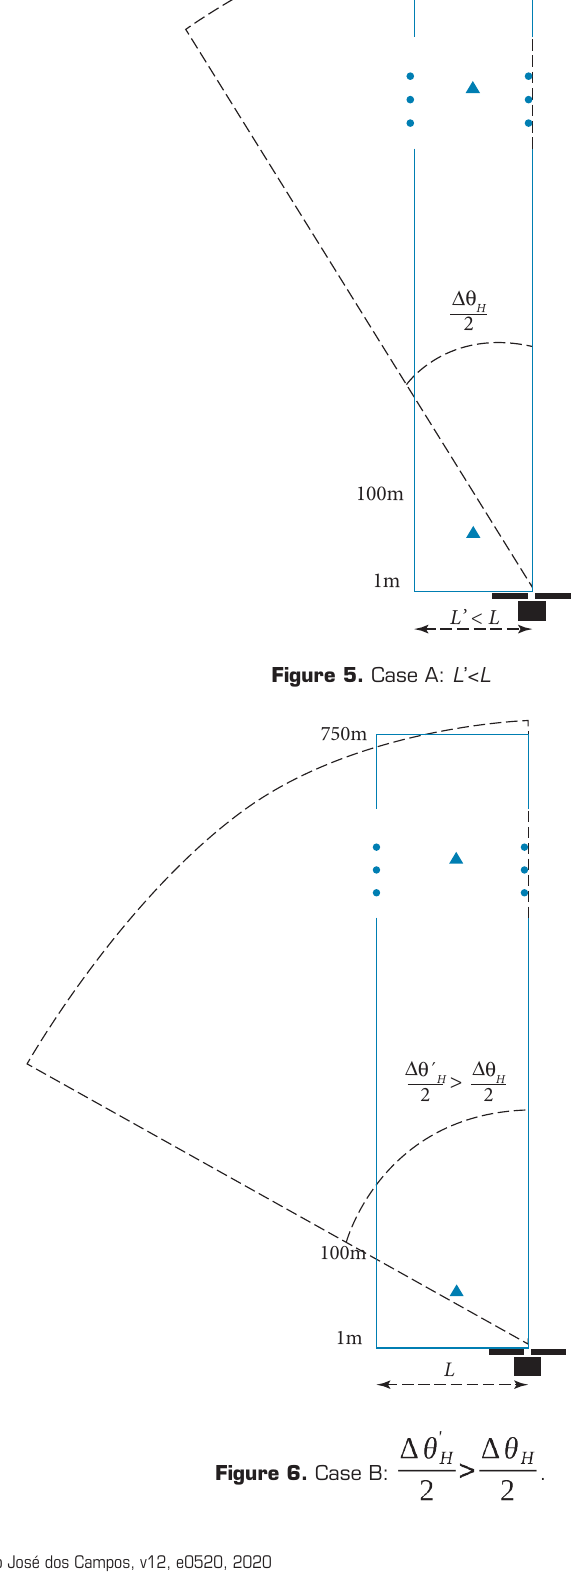
Figure 6. Case B: